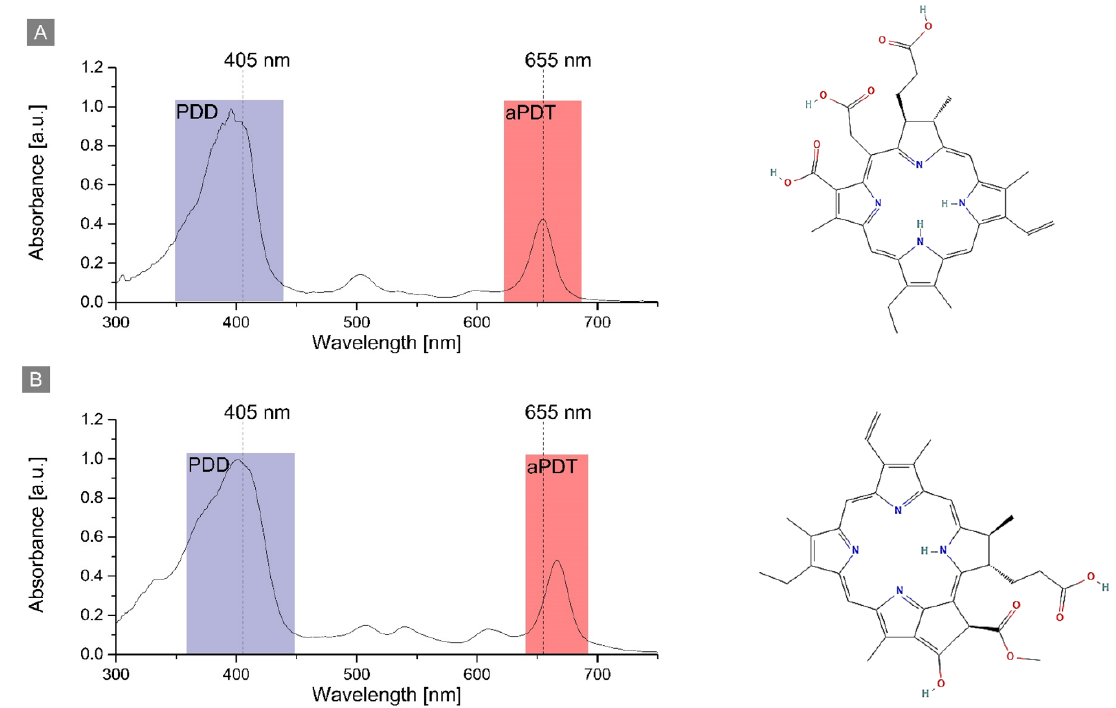
Figure 1. The structure and absorption of ( A ) Chlorin e6 and ( B ) Pheophorbide a in PBS buffer with indication of the used wavelengths for PDD and aPDT.